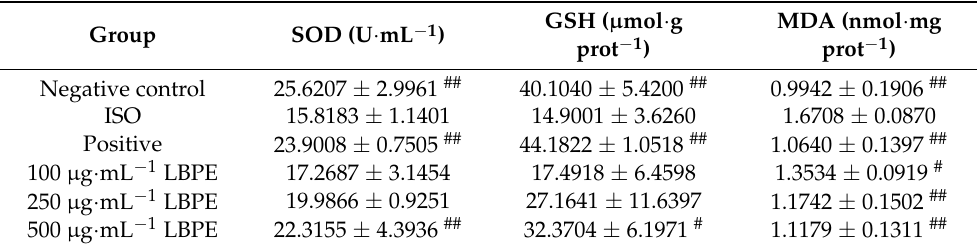
Table 2. Effect of LBPE on SOD, GSH and MDA in H9c2 cells (n = 6). Group SOD (U · mL − 1 ) Negative Group